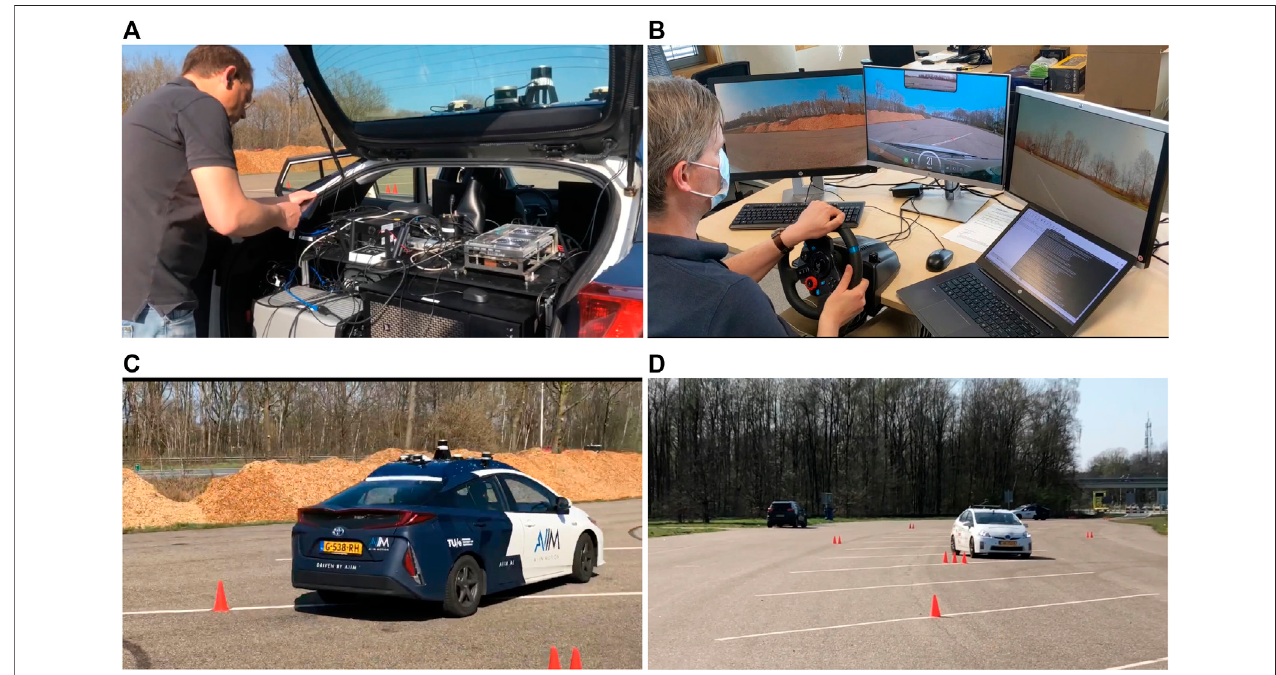
FIGURE 4 | Overview of the setup during testing of straight-line braking and slalom maneuvers showing both vehicles and one of the remote stations in action: (A) trunkofAIIM-TU/ePriusIVwithcomputingsystemsand5G-modeminthemiddle; (B) TU/eremotestationsetupperformingslalomwithSiemensPriusIII(notethesimilar remote station setup as at Siemens in Helmond); (C) AIIM-TU/e Prius IV performing slalom; (D) Siemens Prius III performing remote-driven slalom.